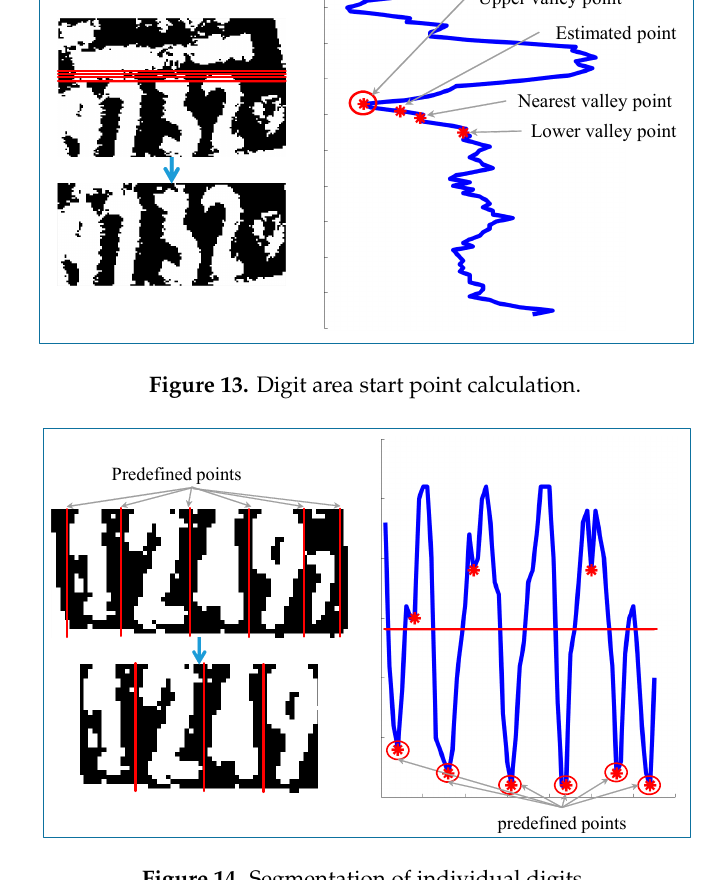
Figure 14. Segmentation of individual digits.